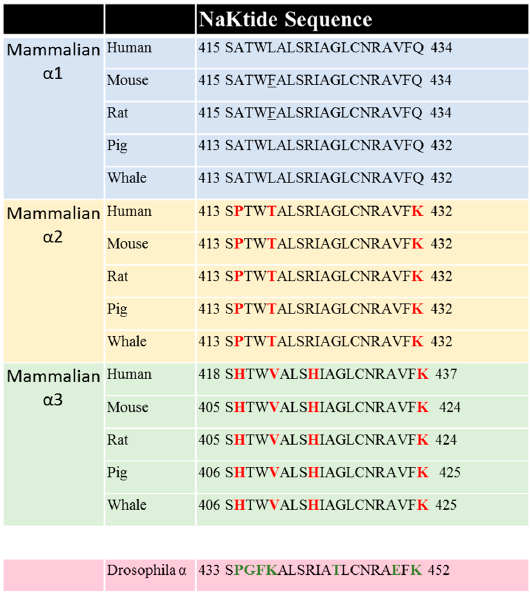
Figure 3. Comparison of NaKtide sequences among different species in α 1, α 2 and α 3 subunits. The amino acids being different from mammalian α 1 are marked in red. Data are from NCBI data base.